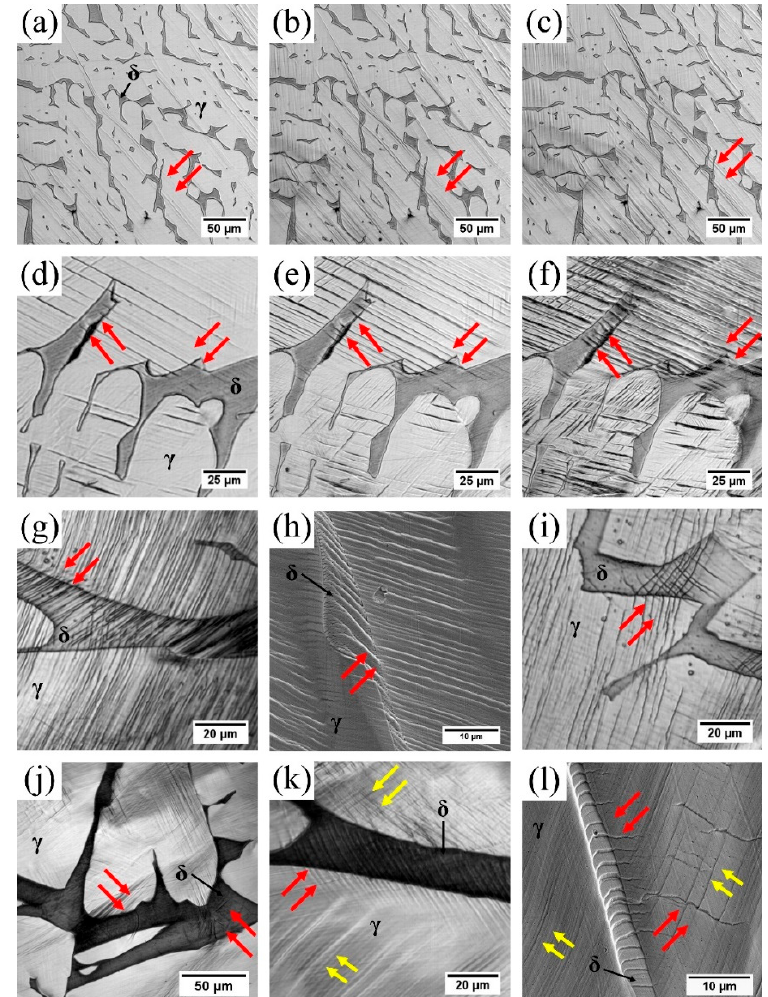
Figure 6. Different types of slip bands between ferrite and austenite phases in Z3CN20.09M CDSS. Figure ( a ) to ( f ) were the microstructure snapshots during the in situ tensile test using the sample with the “as received, 20 °C” condition. Figure ( g ), ( h ) and ( i ) were the results from the samples with the “annealed 3 h, 320 °C” condition. Figure ( j ), ( k ) and ( l ) were microstructures using the sample under the “aged 2000 h, 320 °C” condition. It should be noted that Figure ( h ) and ( l ) were imaged by SEM after the tensile tests and their tensile axis is the vertical direction. In other images, the tensile axis is along the horizontal direction. 𝛾 denotes austenite phase, and 𝛿 is the ferrite phase.